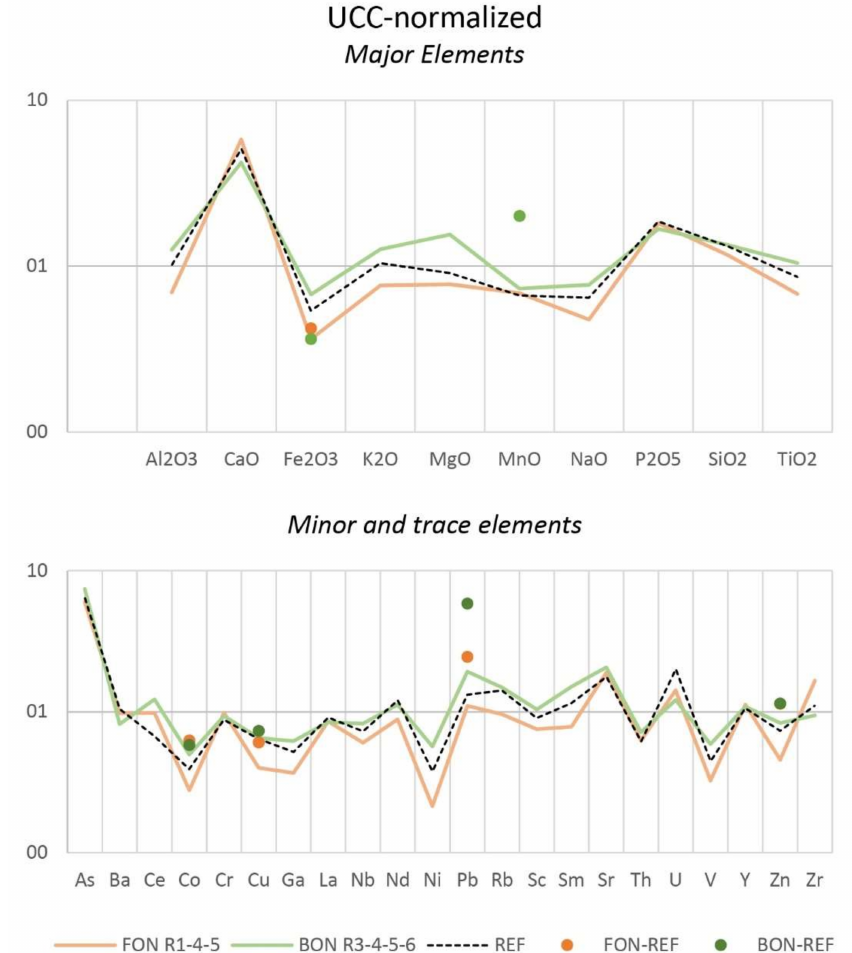
Figure 12. Average values of Fontespina (orange) and Bonaccia (green) sites and their reference sample (REF) normalized to Upper Continental Crust (UCC) according to [39]. Reference data points for both sites averaged sampling stations 1, 40, 76 (for Fontespina site, “REF” orange dots) and 13, 33, 85 (for Bonaccia site, “REF”, green dots) reported elsewhere